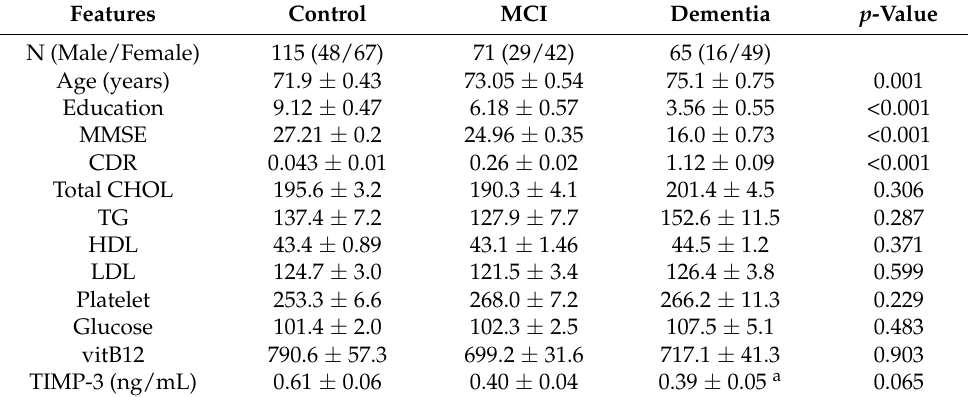
Table 1. Baseline characteristics of the